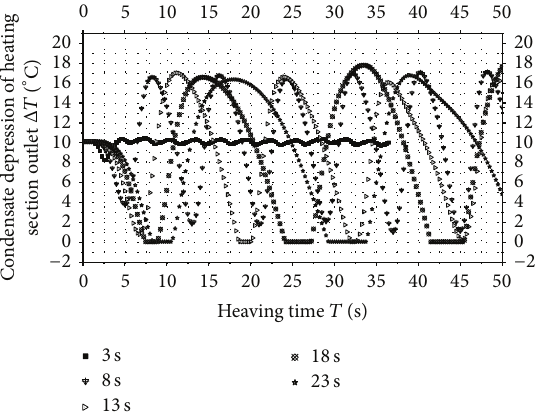
Figure 10: Calculated results of condensate depression of heating section outlet in heaving motion with strength 𝑘 = 0.6 and cycle 𝑇 = 3 s, 8s, 13s, 18 s, and 23 s.